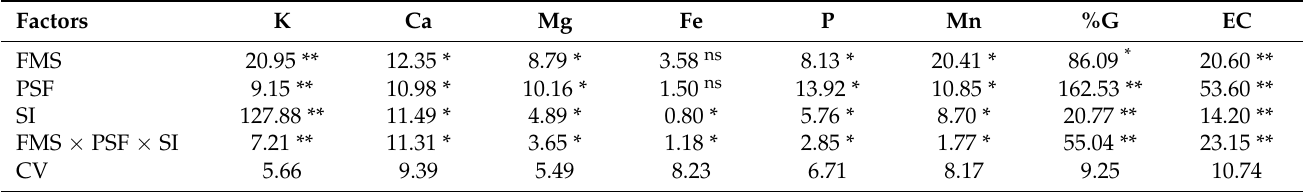
Table 1. Analysis of variance of mineral elements concentration (K, Ca, P, Fe, Mg, and Mn), germi- nation (%G), and electrical conductivity (EC) of habanero pepper seeds extracted from fruits with different stages of maturity (unripe, half-ripe, and ripe) and postharvest storage times (unstored and stored for 7 and 14 days